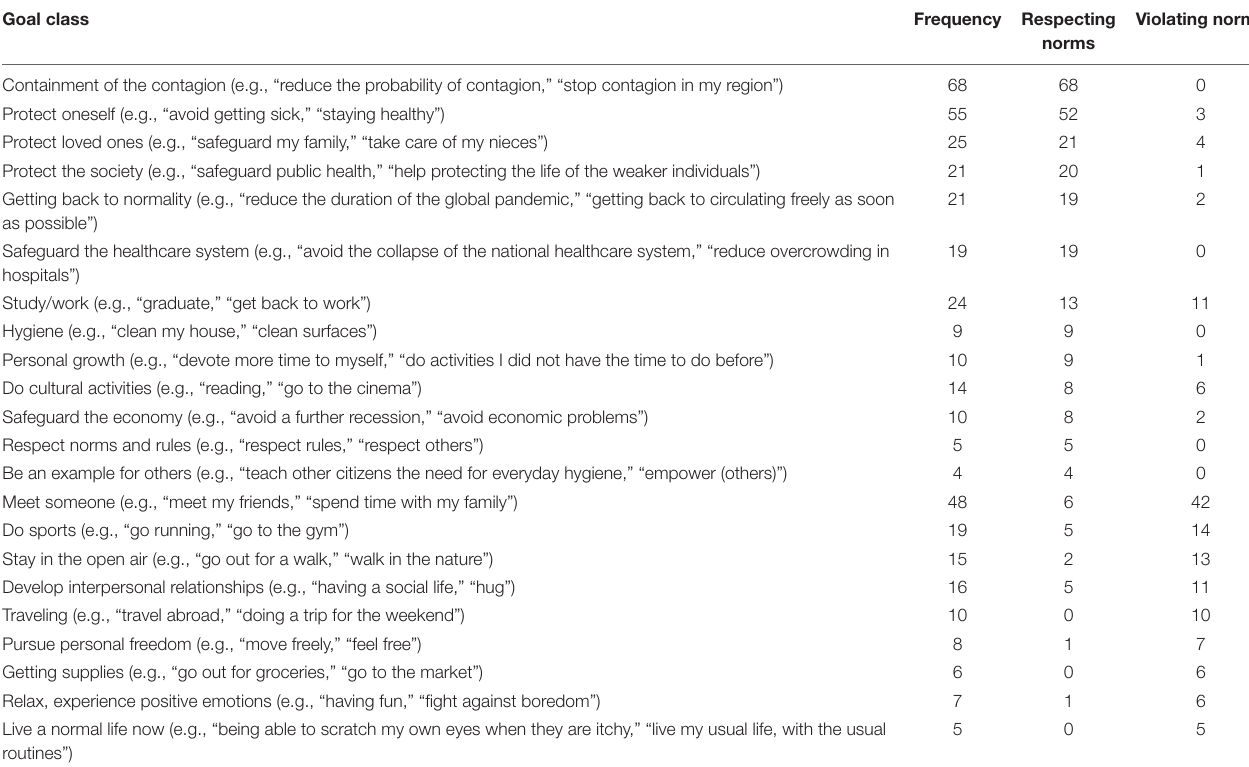
TABLE 1 | Goal classes emerged in Study 1, their frequency, and the number of times they were ascribed to respecting and to violating COVID-mitigation indications. Goal